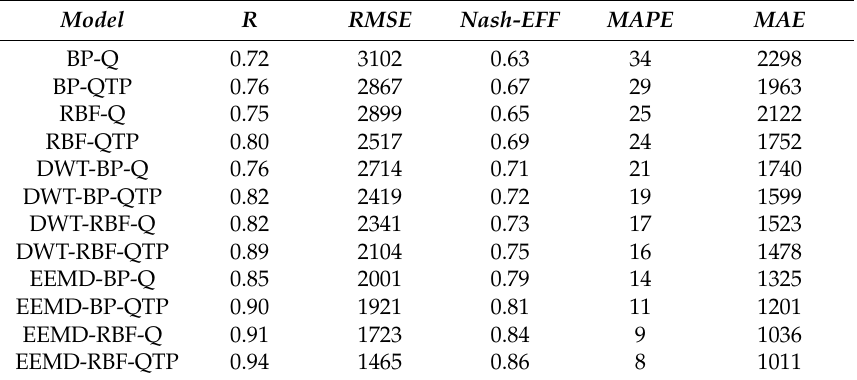
Table 9. Performance evaluation of the applied models for zone two during the validation period.